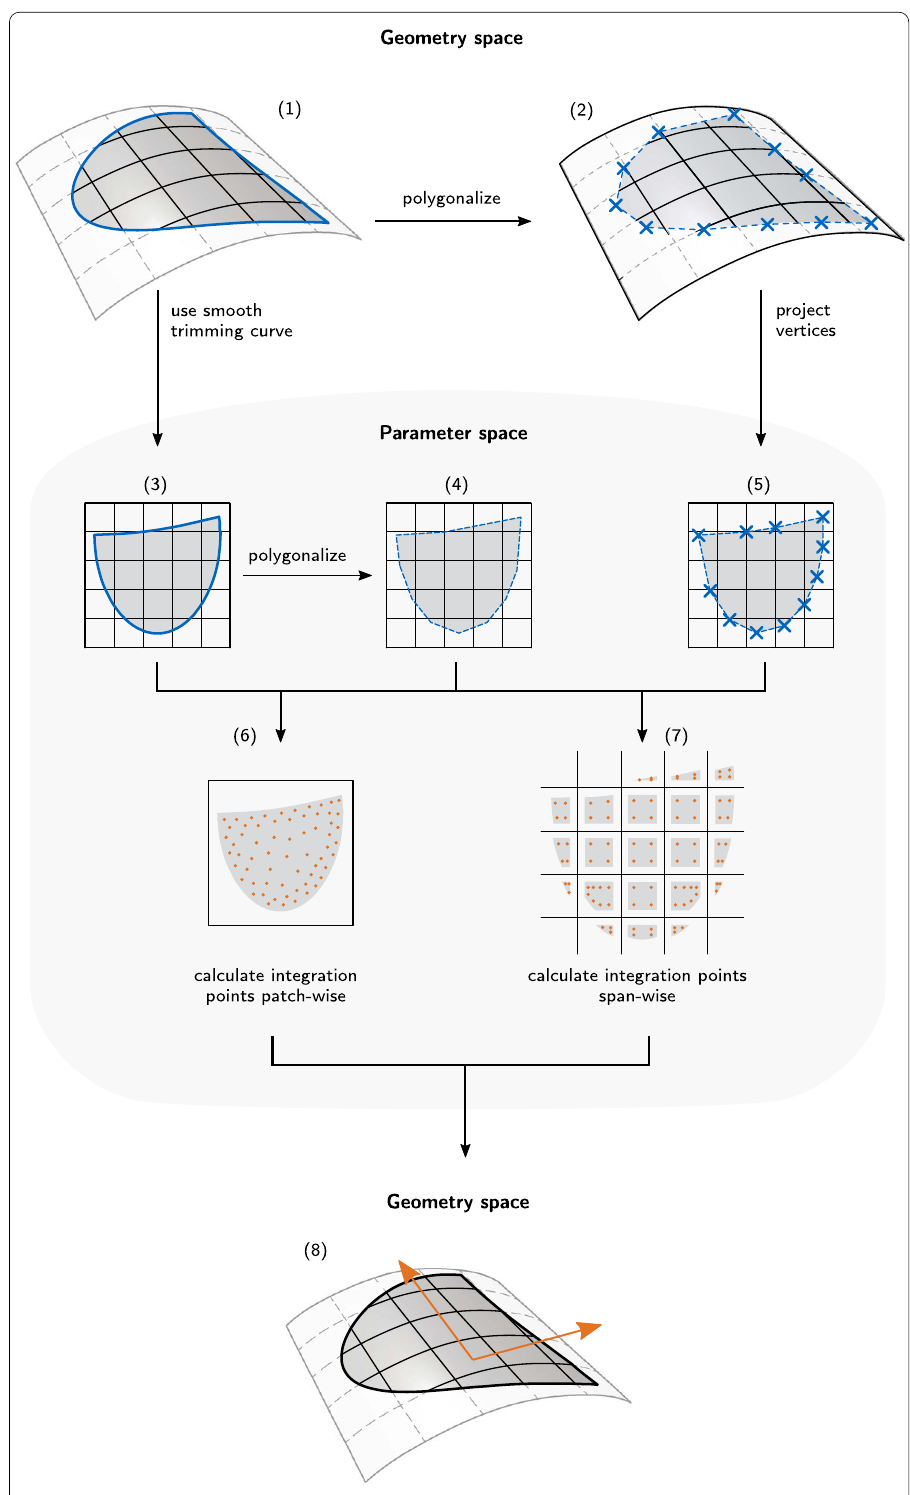
Fig. 6 Different approaches to determine integration points for trimmed surface